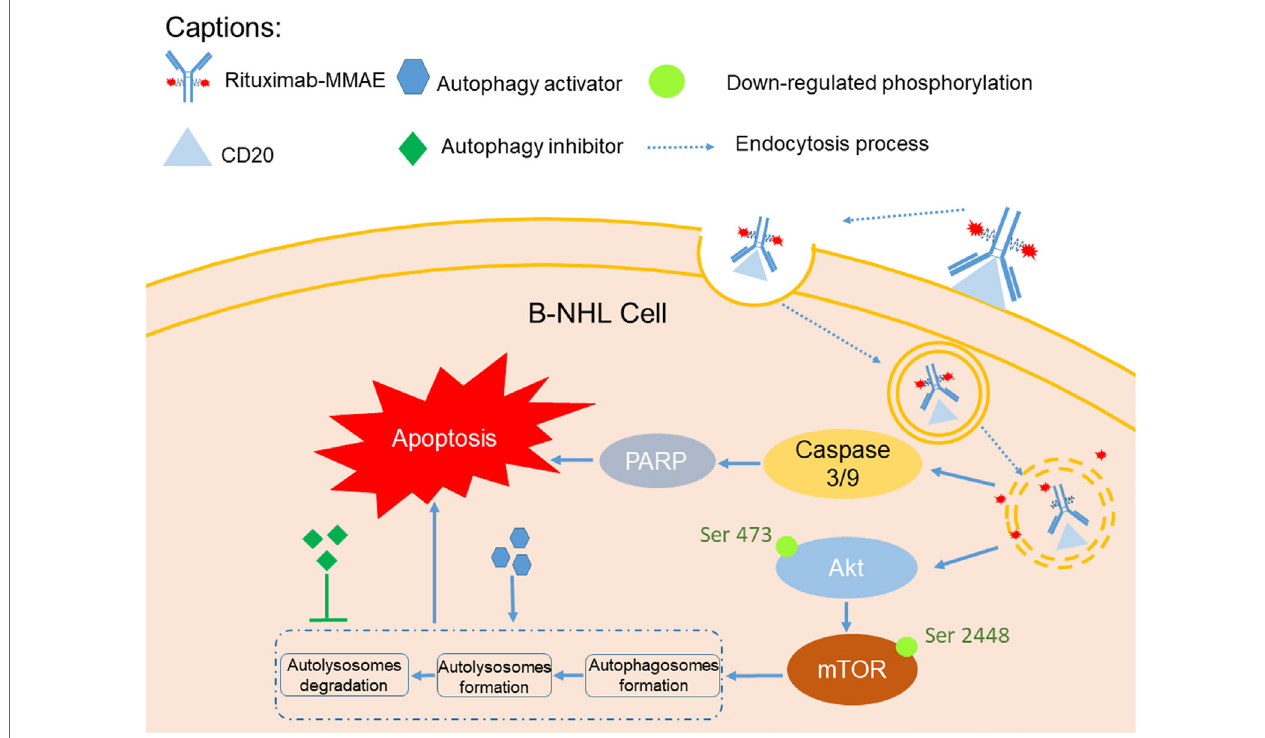
FigUre 7 | A graphical description of how Rituximab-monomethyl auristatin E (MMAE) and autophagy activation could elicit enhanced anti-non-Hodgkin lymphoma (NHL)